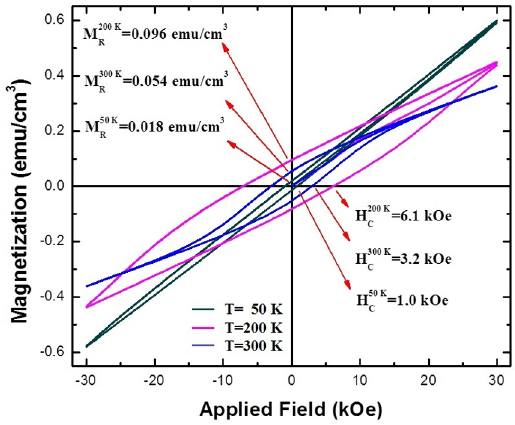
O perovskite and 2 6 O derived from the fit 2 6